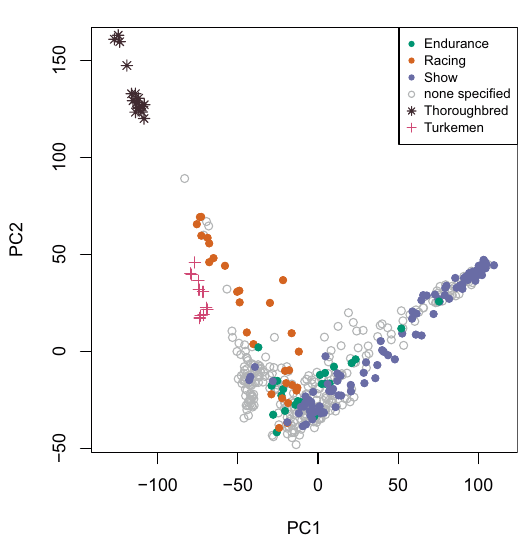
Figure 2. The Arabian breed shows genetic differentiation associated with performance use. Principal components in Fig. 1B were replotted to reflect known competition types for a subset of Arabian horses. Arabian samples were color coded by use (type of competition) in endurance competition, flat course racing or show. Racing horses (orange) plot in the PCA space between the Thoroughbred racehorse and other subgroups of Arabian